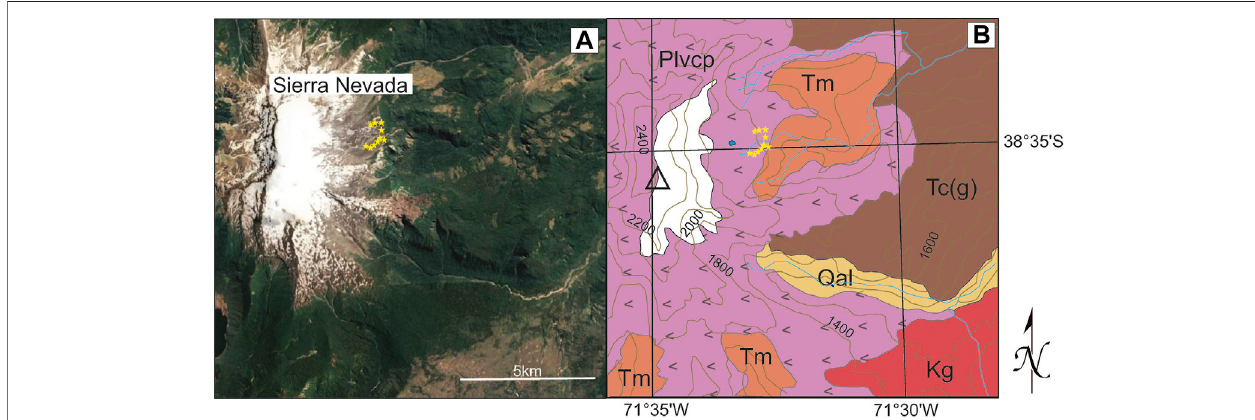
FIGURE 2 | Panel (A) Google Earth map of Monte Sierra Nevada and surrounding area with sample locations marked by yellow stars. Panel (B) Geologic map, modi fi ed from Muñoz et al. (2011). Qal — Quaternary alluvium, Plvcp — Upper Pleistocene-Holocene volcanic rocks, Tc — Miocene Cura-Mallin Formation, Tm — Miocene Melipeuco Plutonic Group, Kg — Cretaceous Galletué Plutonic Group.